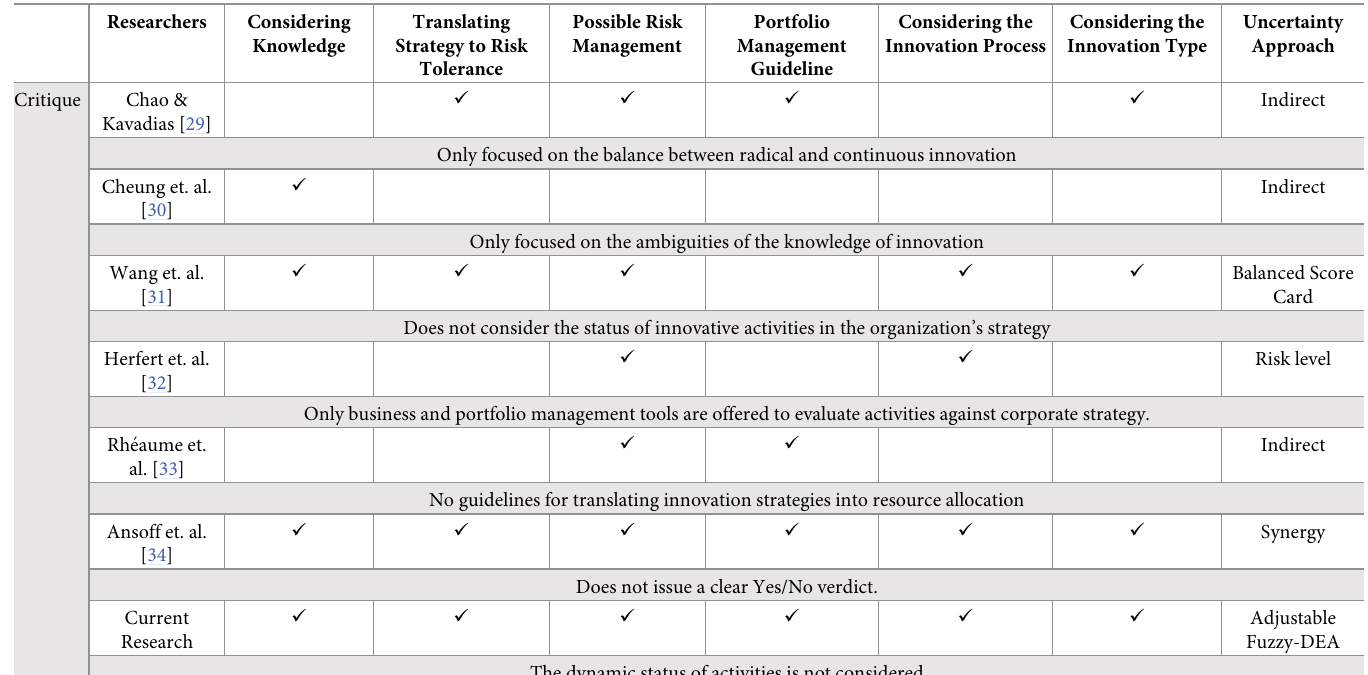
Table 2. Major pieces of research on strategic evaluation of innovative activities under